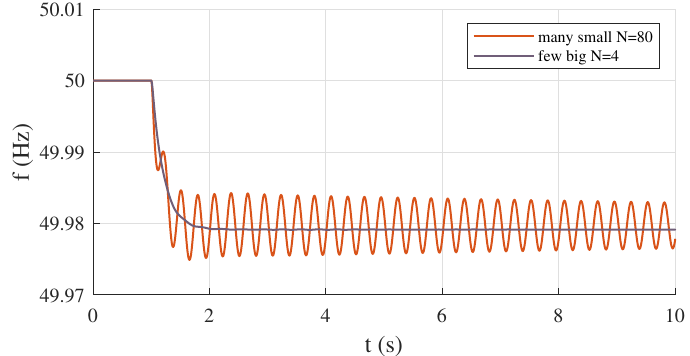
Figure 9. Impact of number of grid-forming